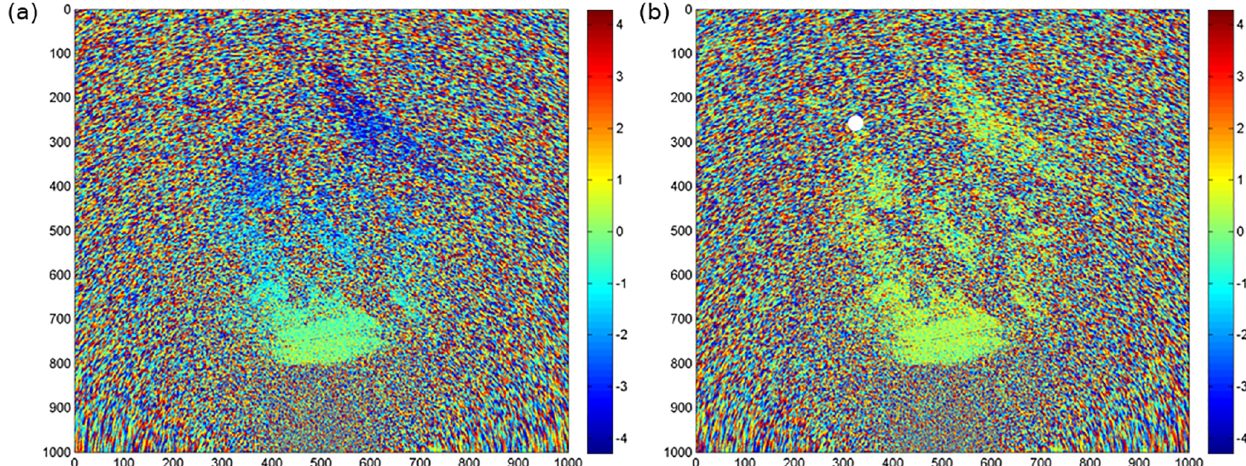
Figure 4. The color bar is expressed in millimeters; green indicates stable pixels, while blue and red respectively indicate movement to- ward and away from the GB-InSAR. (a) Raw interferogram showing artificial displacement increasing linearly with distance (as typical of atmospheric noise). (b) The same interferogram after the atmospheric correction.